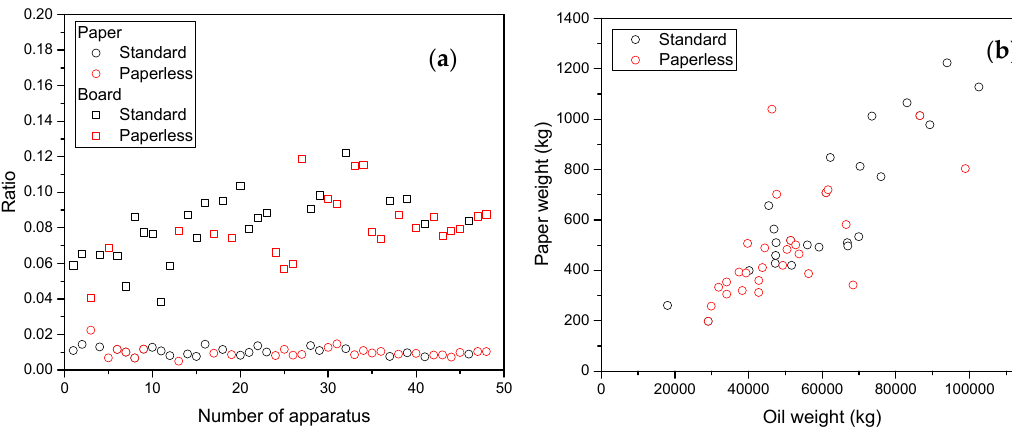
Figure 15. ( a ) Ratio of solid insulation of different core-type transformers. ( b ) Paper weight versus oil weight for different core-type transformers [87].